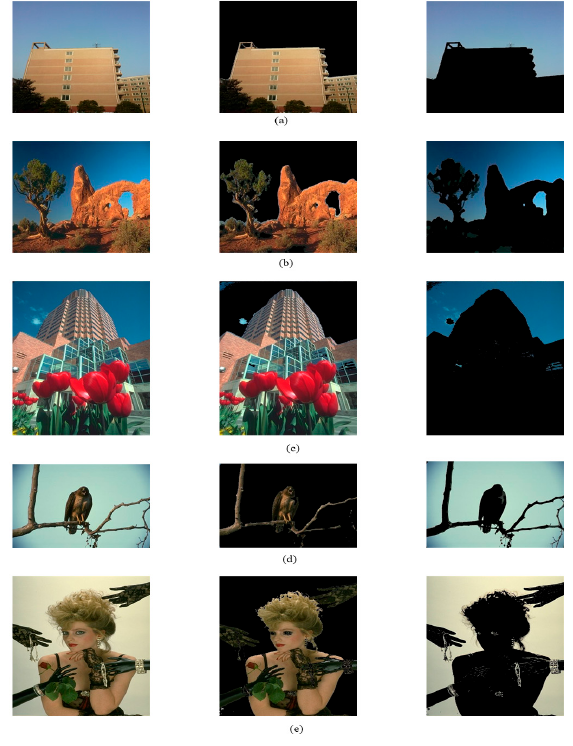
Figure 24. Image fusion results.